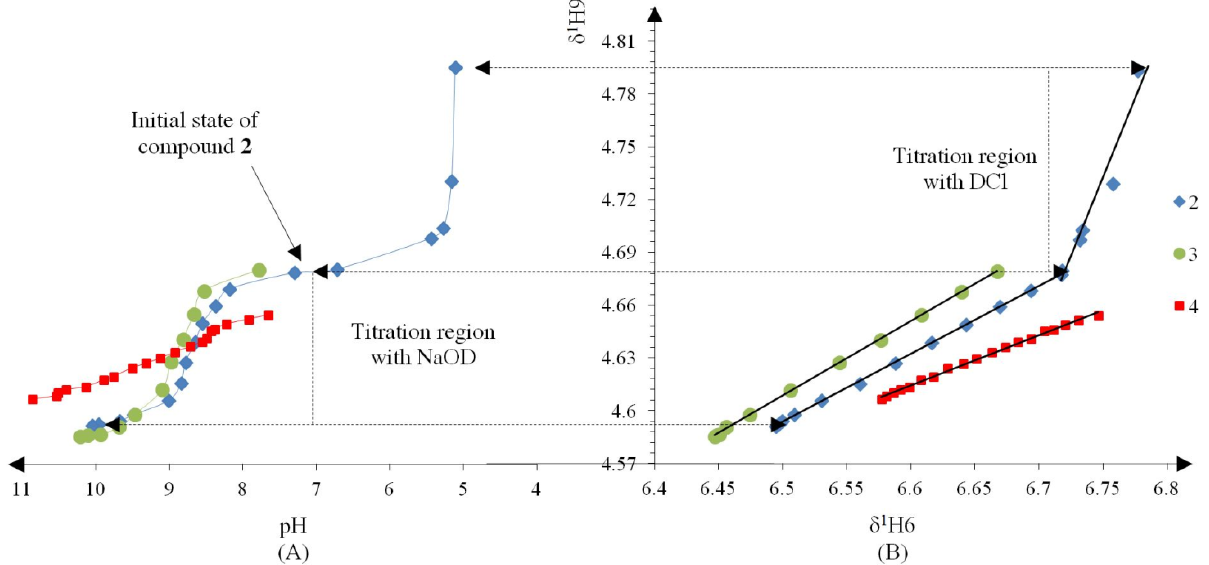
Figure 2. ( A ) Titration curve of compounds 2 – 4 ; compound 2 was titrated with DCl; only the titration region with NaOD was used to calculate the pK Hasselbalch equation; ( B ) δ -Diagram of δ 1 obtained was not linearized but after using the Perrin model the data became for